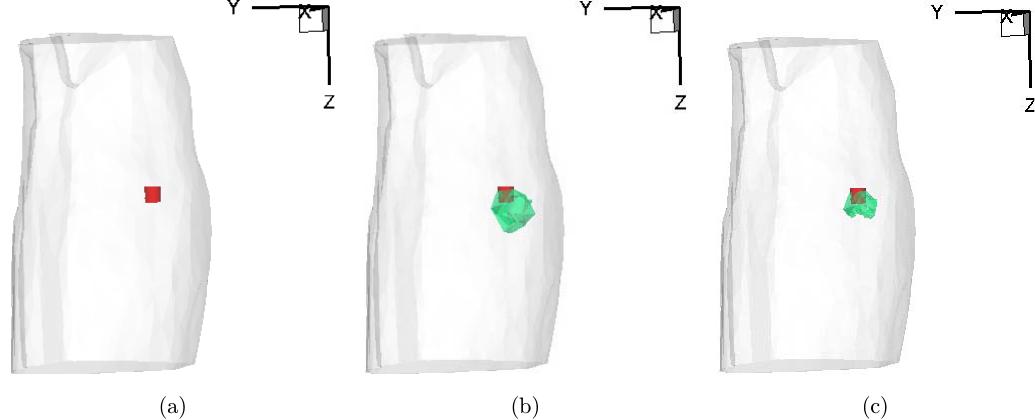
Fig. 1. Di®erent reconstruction regions at di®erent mesh levels. The red cylinder is the °uorescent target. (a) The reconstruction region for the ¯rst mesh level consists of the entire mouse torso. (b) The green zone is the reconstruction region at the second level. (c) The green zone is the reconstruction region at the third